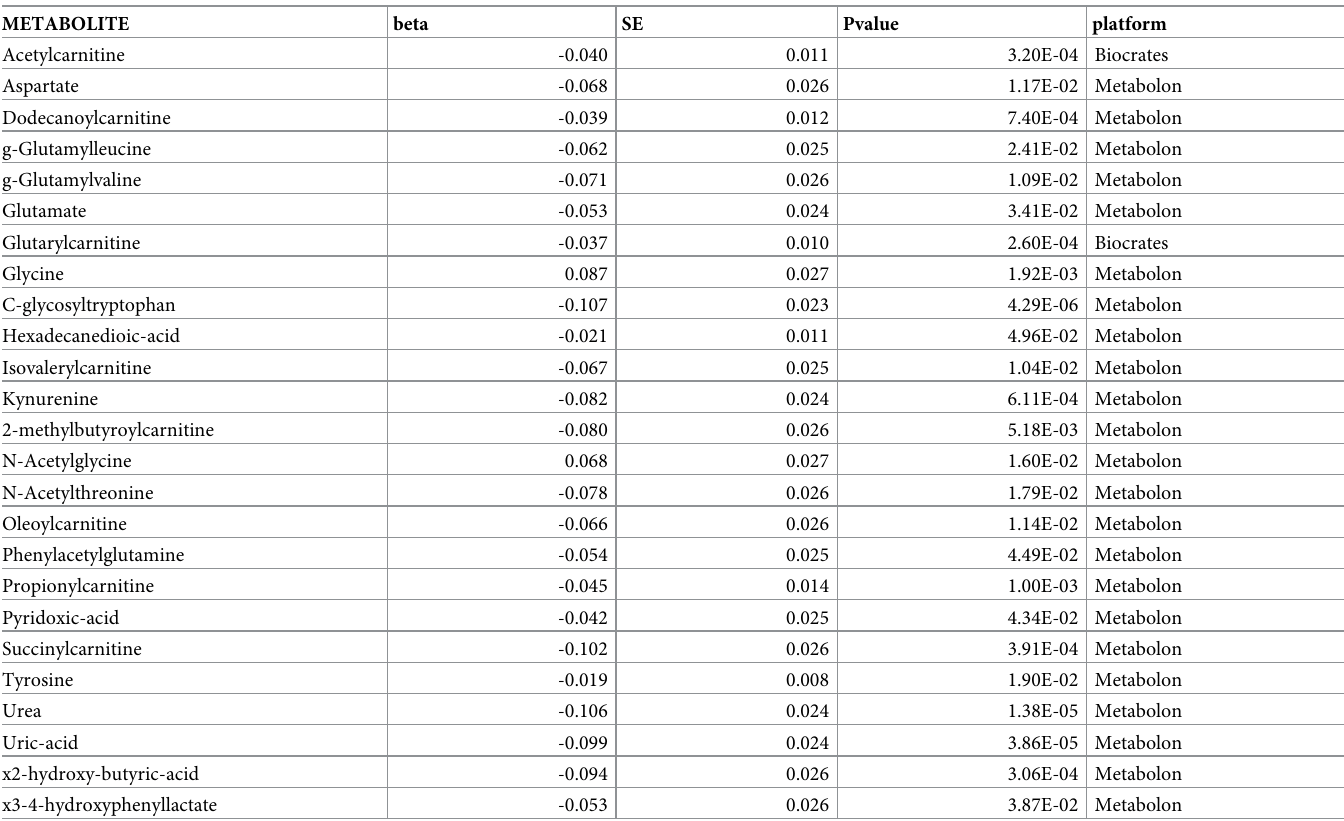
Table 2. Metabolites associated with birthweight in the TwinsUK